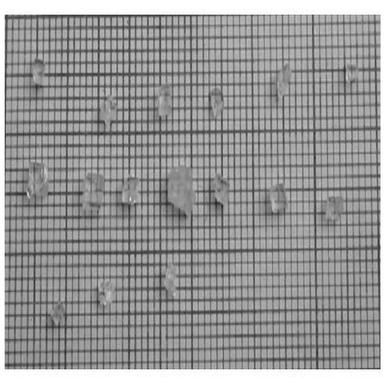
EDX spectrum of ATZC crystal.